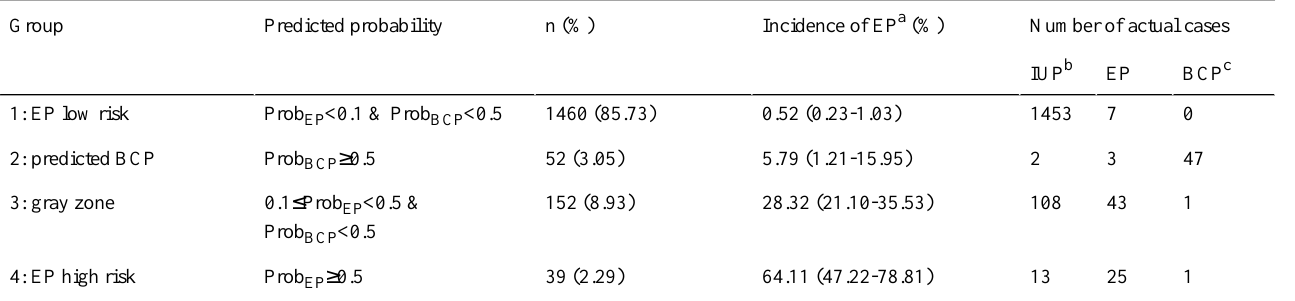
Table 4. Classification according to the incidence of ectopic pregnancy